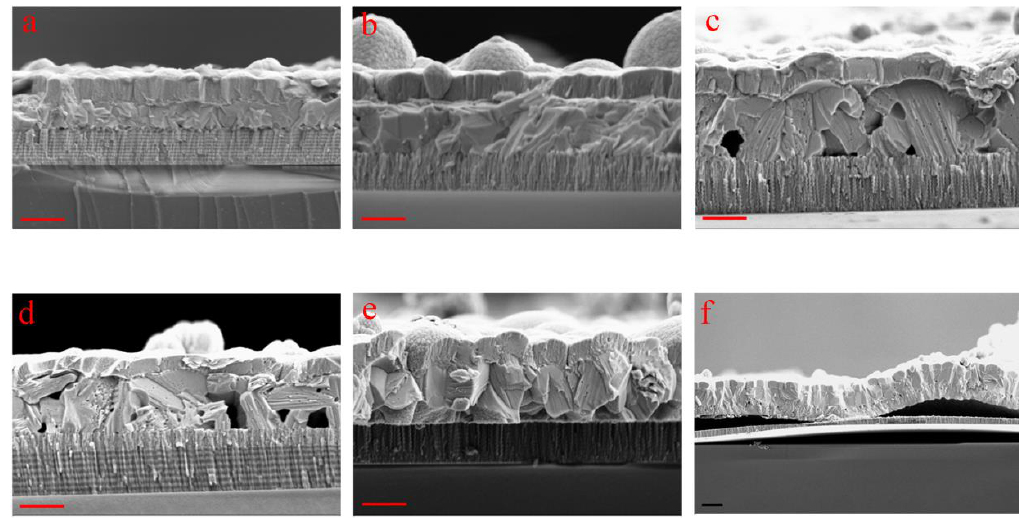
Figure 3. SEM cross-sectional images of Sb 2 Se 3 devices sputtered under 2.0 Pa ( a ), 1.5 Pa ( b ), 1.0 Pa ( c ), 0.5 Pa ( d ), mixed pressures ( e ), and 0.1 Pa ( f ). The red scale bars at the left bottom corner of ( a – e ) read 1 µm. The black scale bar at the left bottom corner of ( f ) reads 2 µm.